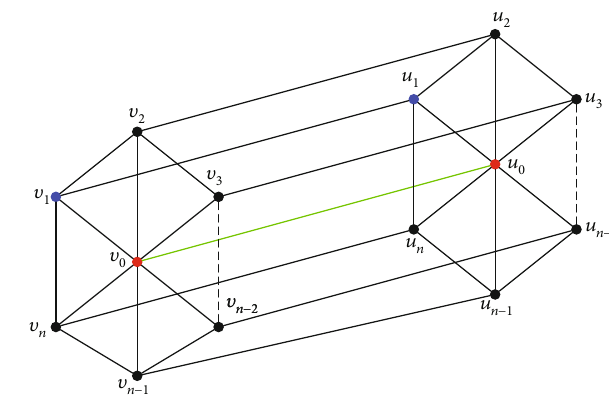
Figure 9: The prism of the wheel P ð W